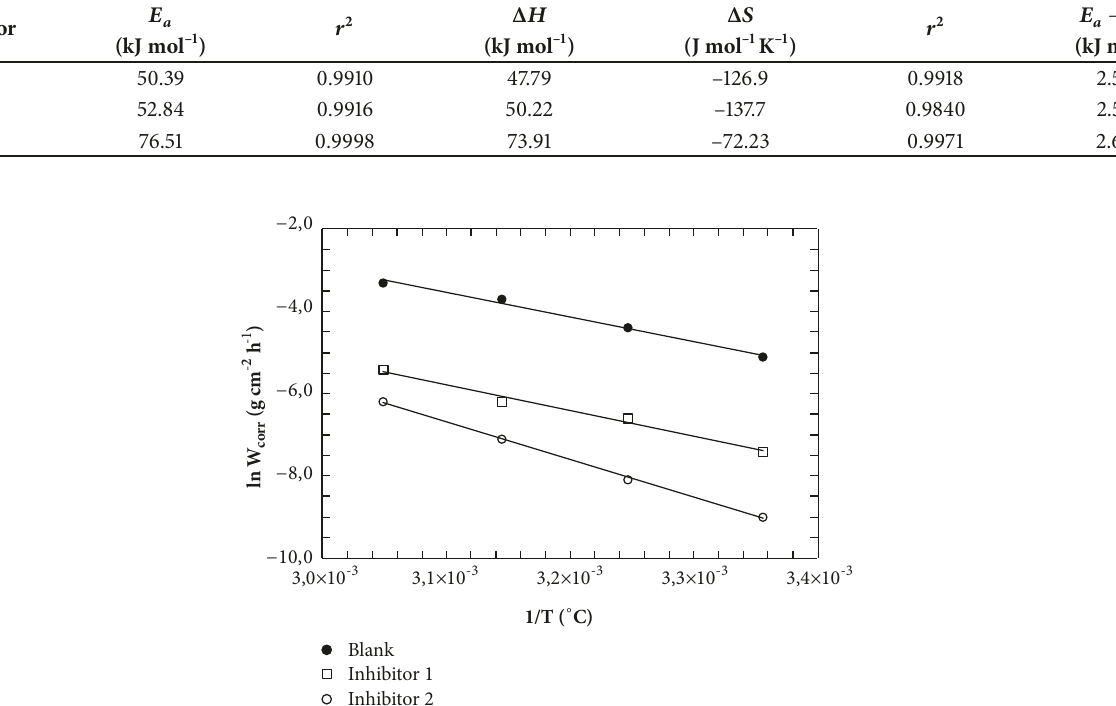
Figure 3: Arrhenius plots of ln W corr versus 1/T in the absence and presence of 250mg L – 1 of inhibitors compounds.